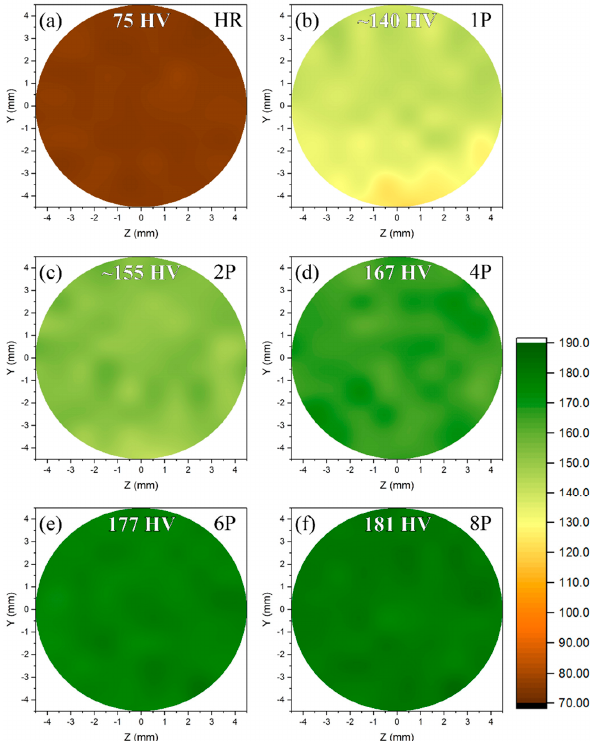
Figure 3. Color-coded contour maps of the hardness on the transverse section of the Cu-Mg alloy ( a ) before the ECAP process and after ( b ) 1, ( c ) 2, ( d ) 4, ( e ) 6 and ( f ) 8 ECAP passes.